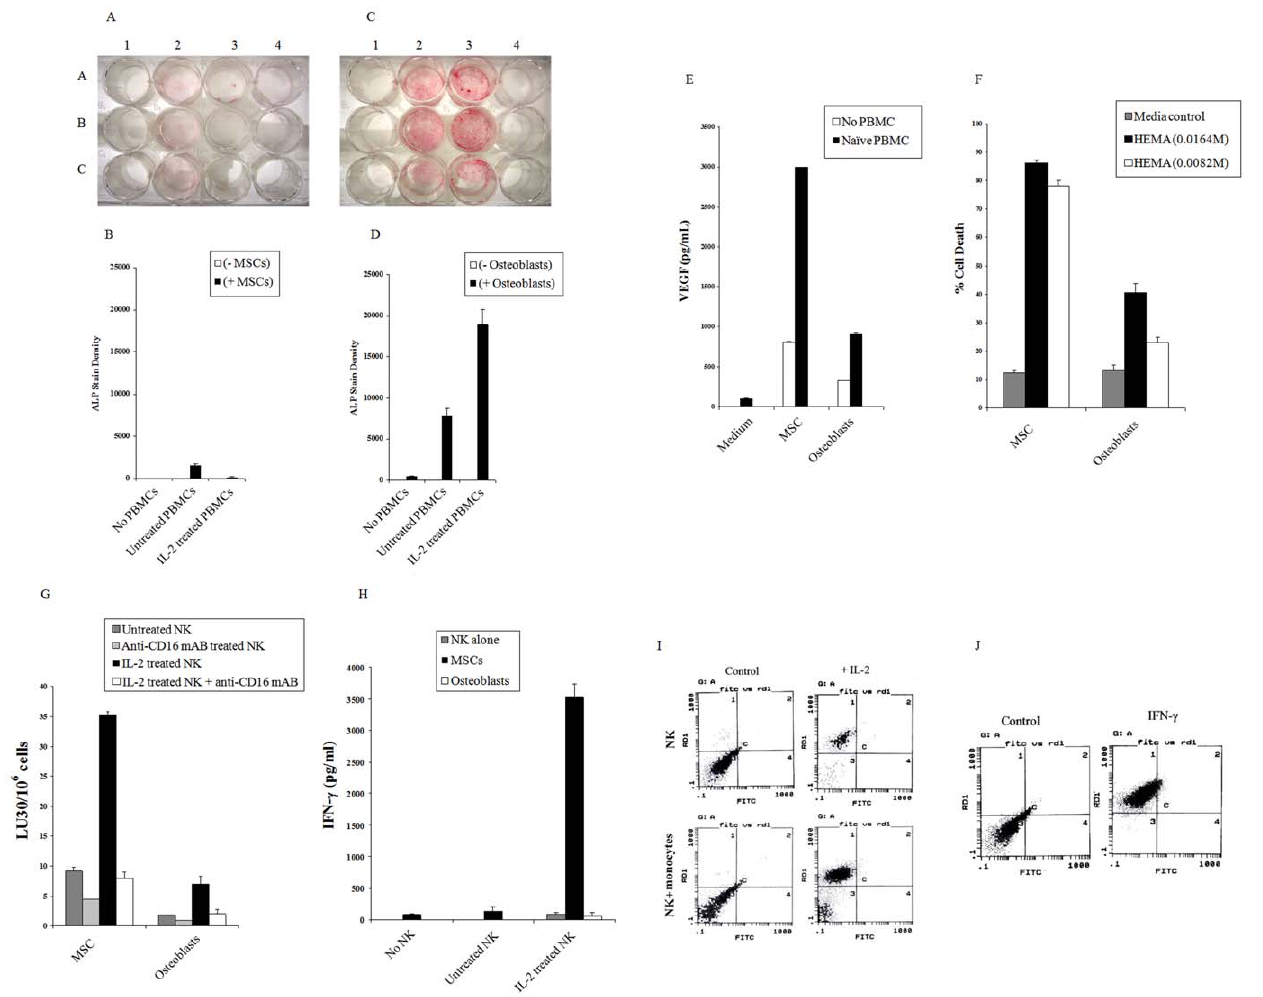
monocytes had very little cytotoxicity. Similarly, NK cells purified from Cox-2flox/flox LysMCre/ + mice and cultured with autologous COX2 2 / 2 monocytes secreted higher levels of IFN- c when compared to NK cells from control mice ( Cox-2flox/flox LysM + / + ) cultured with autologous COX2 + / + monocytes (Fig.